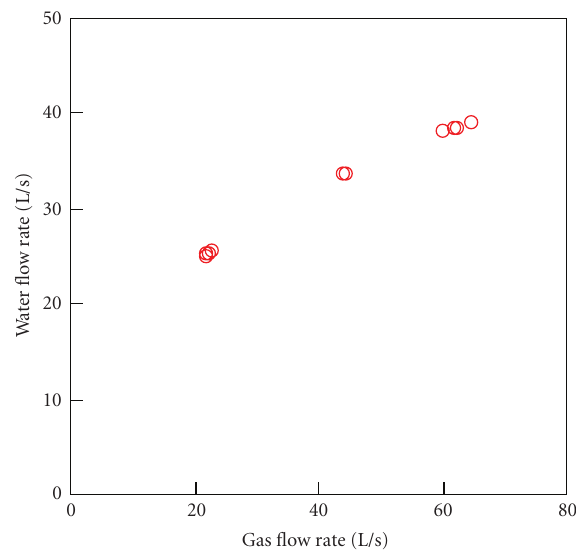
Figure 10: Dependence of induced waters flow rate versus injected air flow